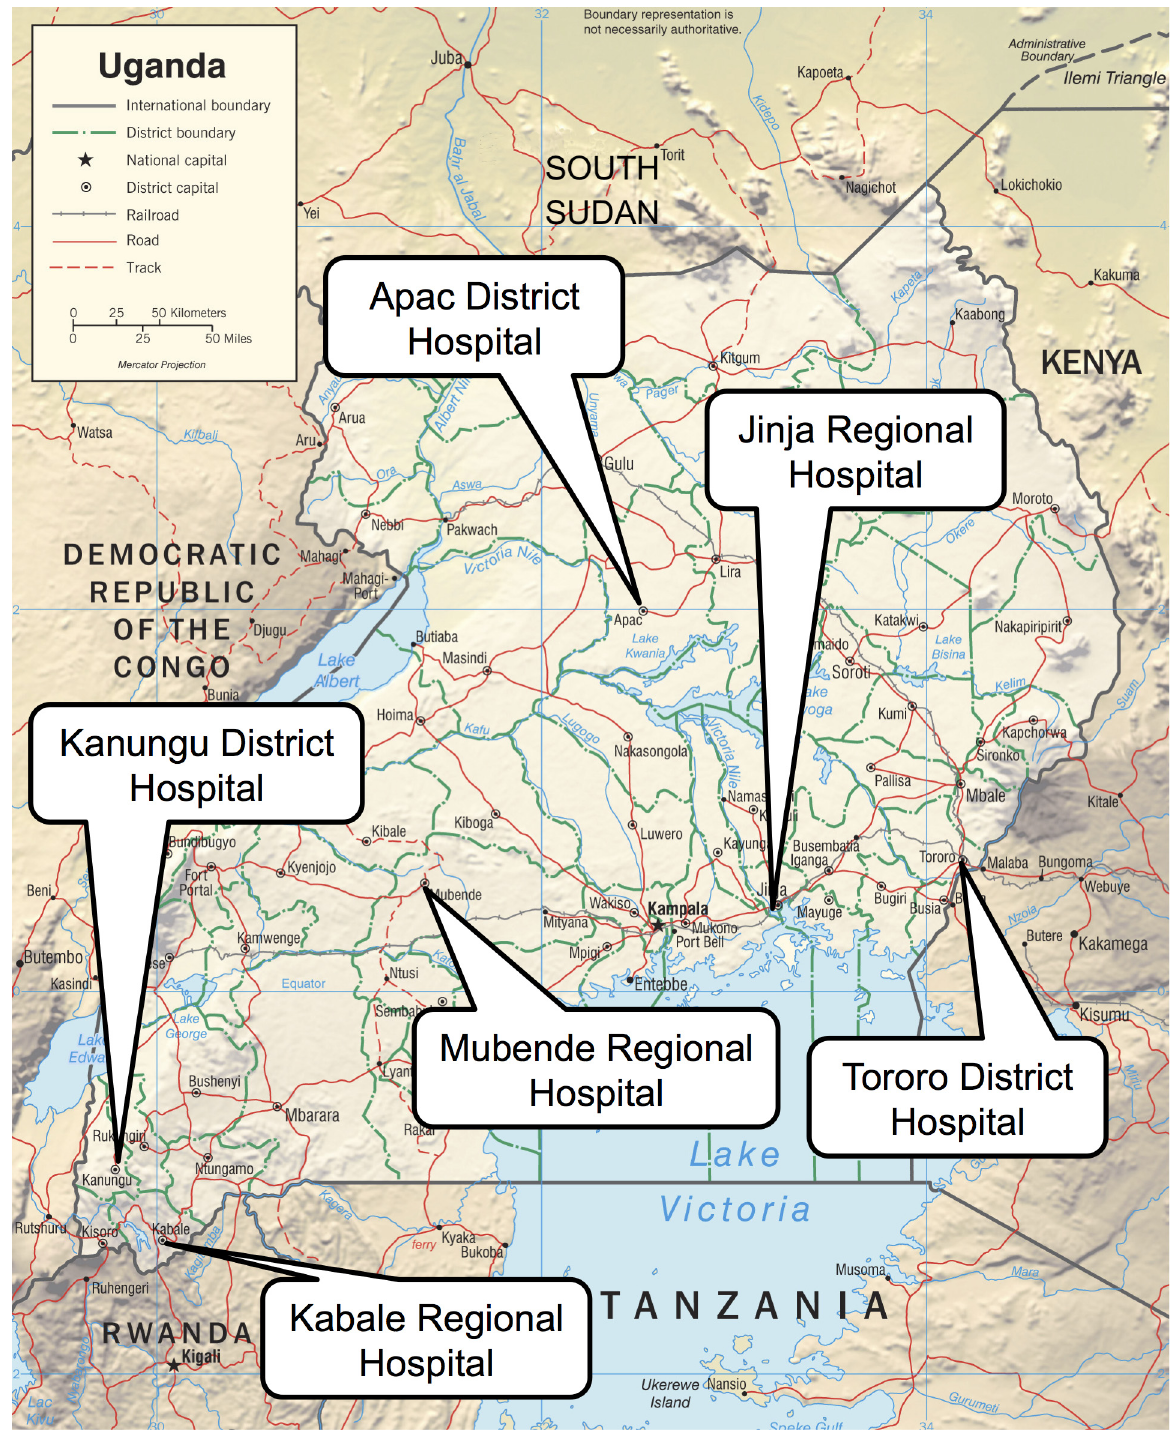
Fig 1. Location of the six hospitals participating in the UMSP health facility-based surveillance program [Image adapted from the original (source: https://www.cia.gov/library/publications/cia-maps-publications/map-downloads/uganda-physiog.jpg/image.jpg)].